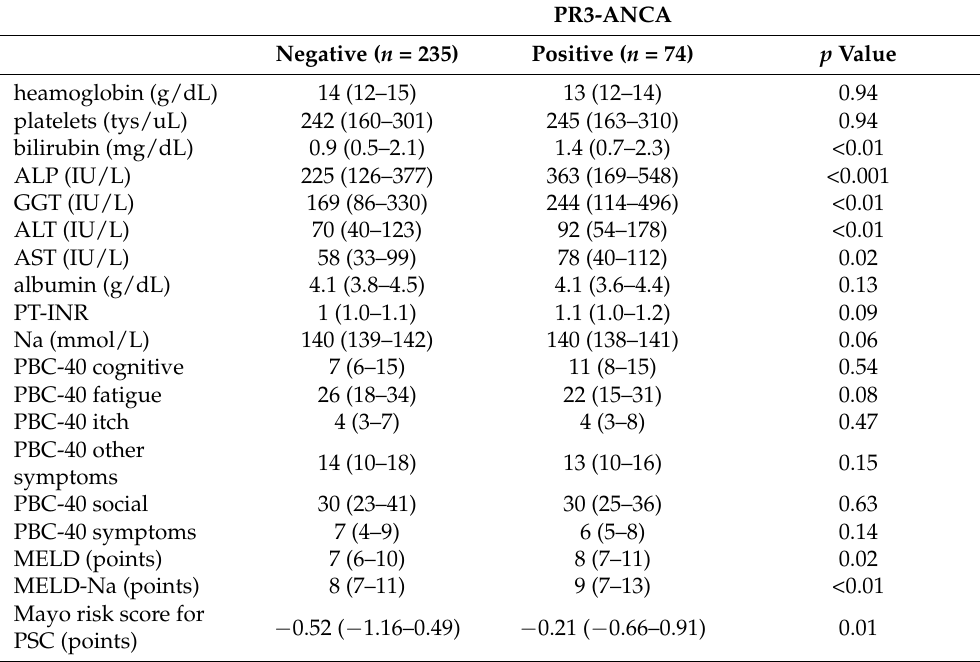
Table 4. Association of PR3-ANCA positivity with laboratory parameters and risk scores in 309 patients with primary sclerosing cholangitis. Data presented as median with interquartile range. Ab- breviations: alanine aminotransferase, ALT; alkaline phosphatase, ALP; aspartate aminotransferase, AST; gamma glutamyltransferase, GGT; primary biliary cholangitis disease specific quality of life measure, PBC-40; international normalised ratio for prothrombin time, PT-INR; model for end-stage liver disease, MELD; primary sclerosing cholangitis,